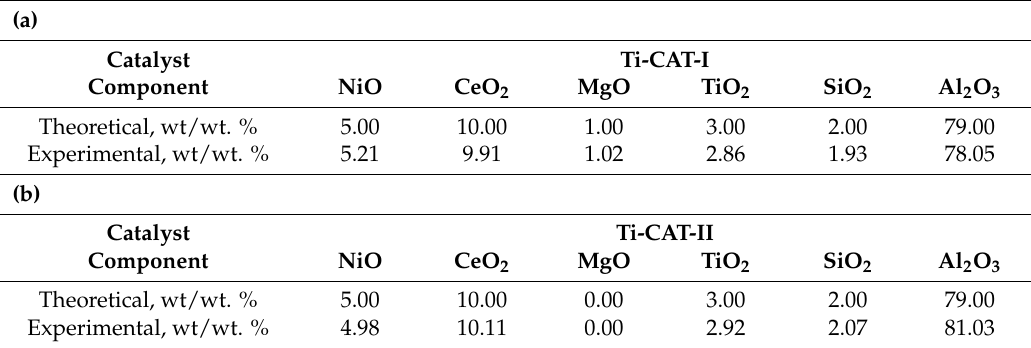
Table 1. ICP metal oxide microanalysis of